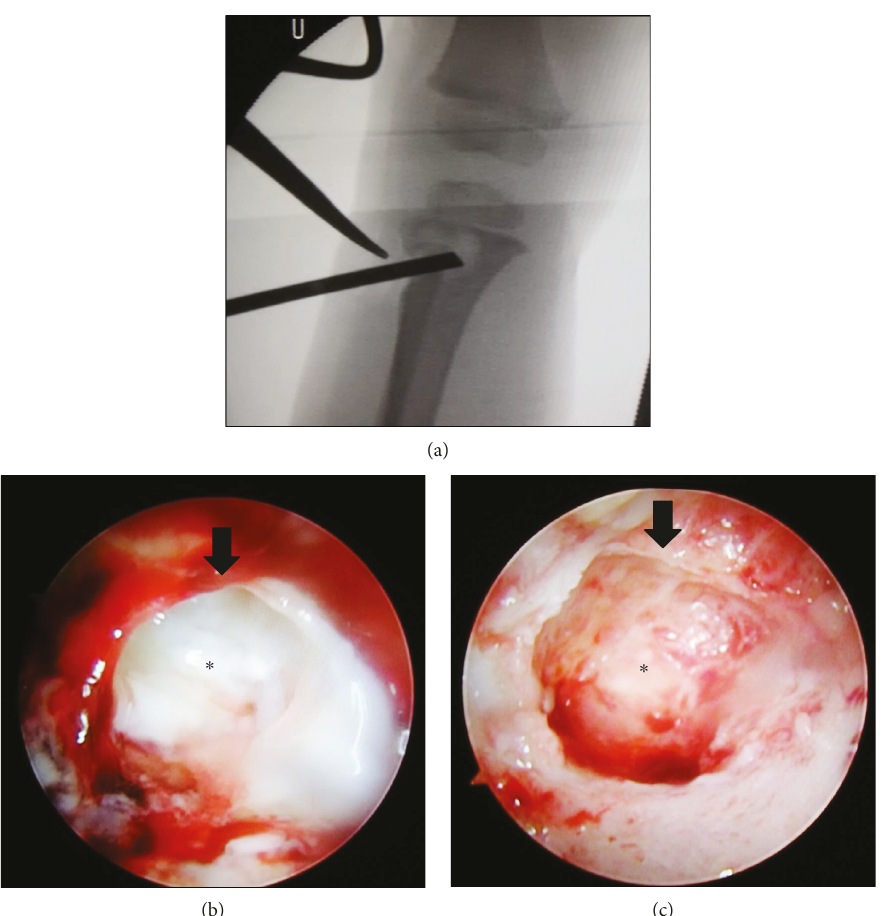
Figure 5: Endoscopic view from metaphysis to epiphysis through physis. (a) Endoscopic view under fl uoroscopic guidance. (b) Lesion before drainage. (c) Lesion after drainage. Arrow: physis. ∗